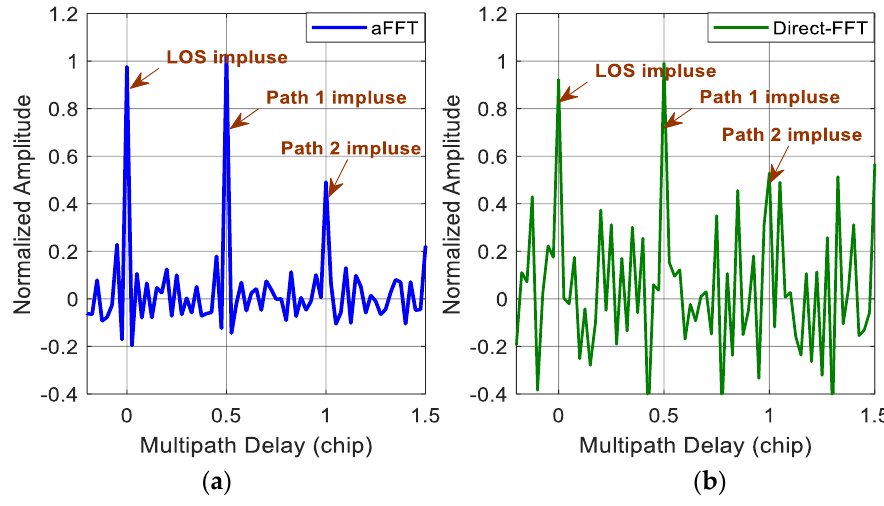
Figure 4. ( a ) Impulse responses of the averaging-FFT method with C/N 0 of 38 dB-Hz; ( b ) impulse responses of the direct-FFT method with C/N 0 of 38 dB-Hz.